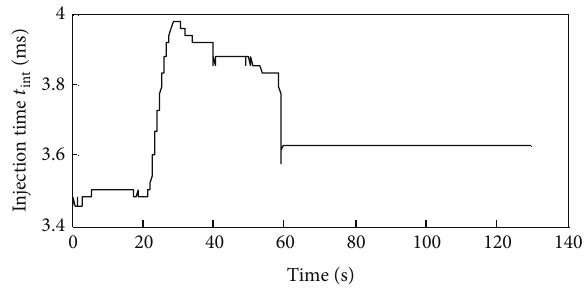
Figure 19: Injection duration of engine operation